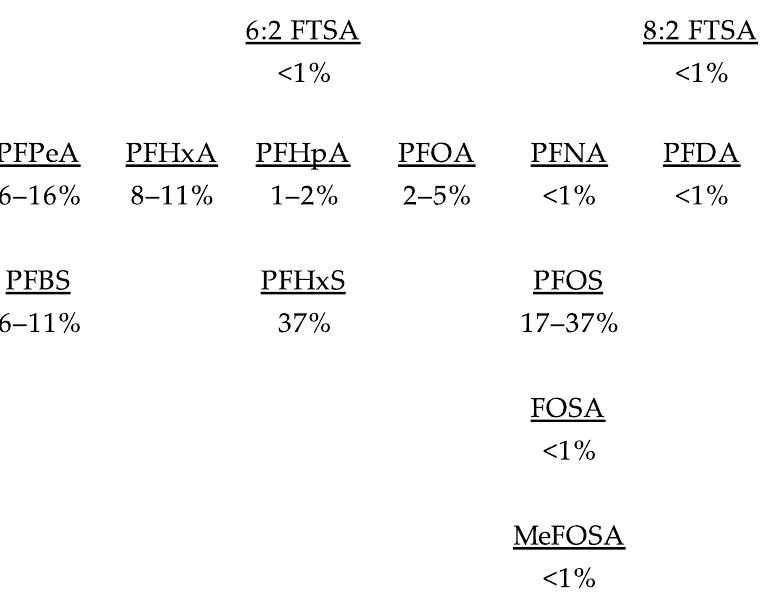
Figure 1. PFAS profile detected in the POCIS deployed at GW1 and GW3 (sorted left to right according to fluorinated chain length).